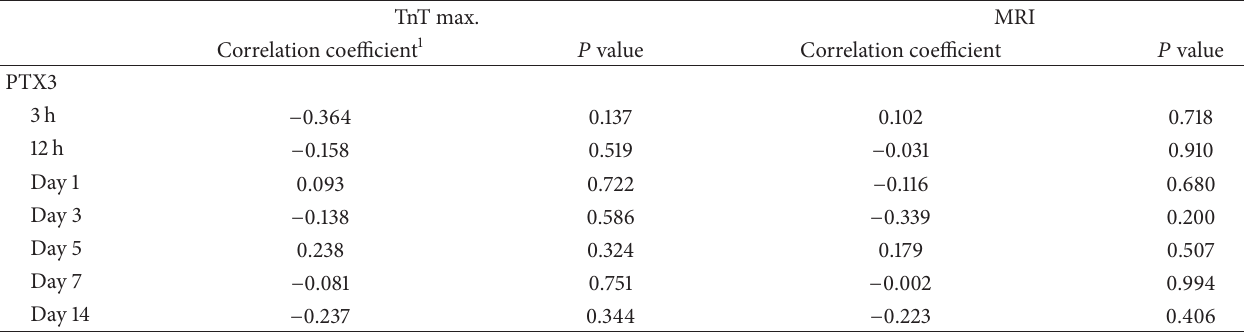
Table 2: Correlations between circulating PTX3 levels and infarct size.